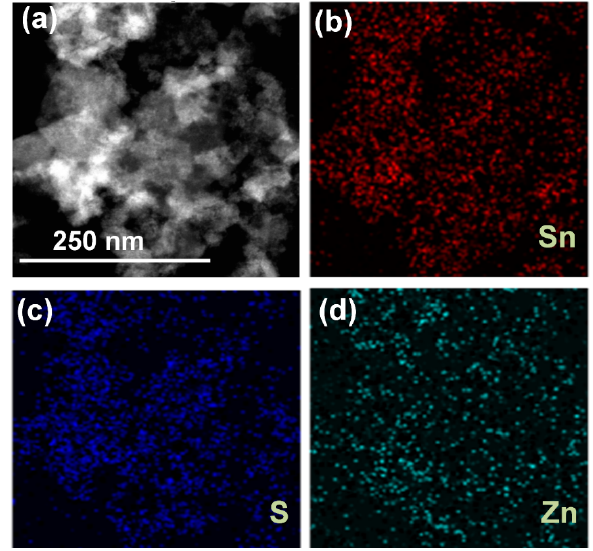
Figure 3. ( a ) TEM image of Sn 0.97 Zn 0.03 S 2 nanoflakes and Energy dispersive spectroscopy (EDS) elemental mapping of Sn ( b ), S ( c ) and Zn ( d ) from selected area for 2D Sn 0.97 Zn 0.03 S 2 . The crystallographic pattern of as synthesized SnS 2 , Sn 0.99 Zn 0.01 S 2 and Sn 0.97 Zn 0.03 S 2 nanoflakes are